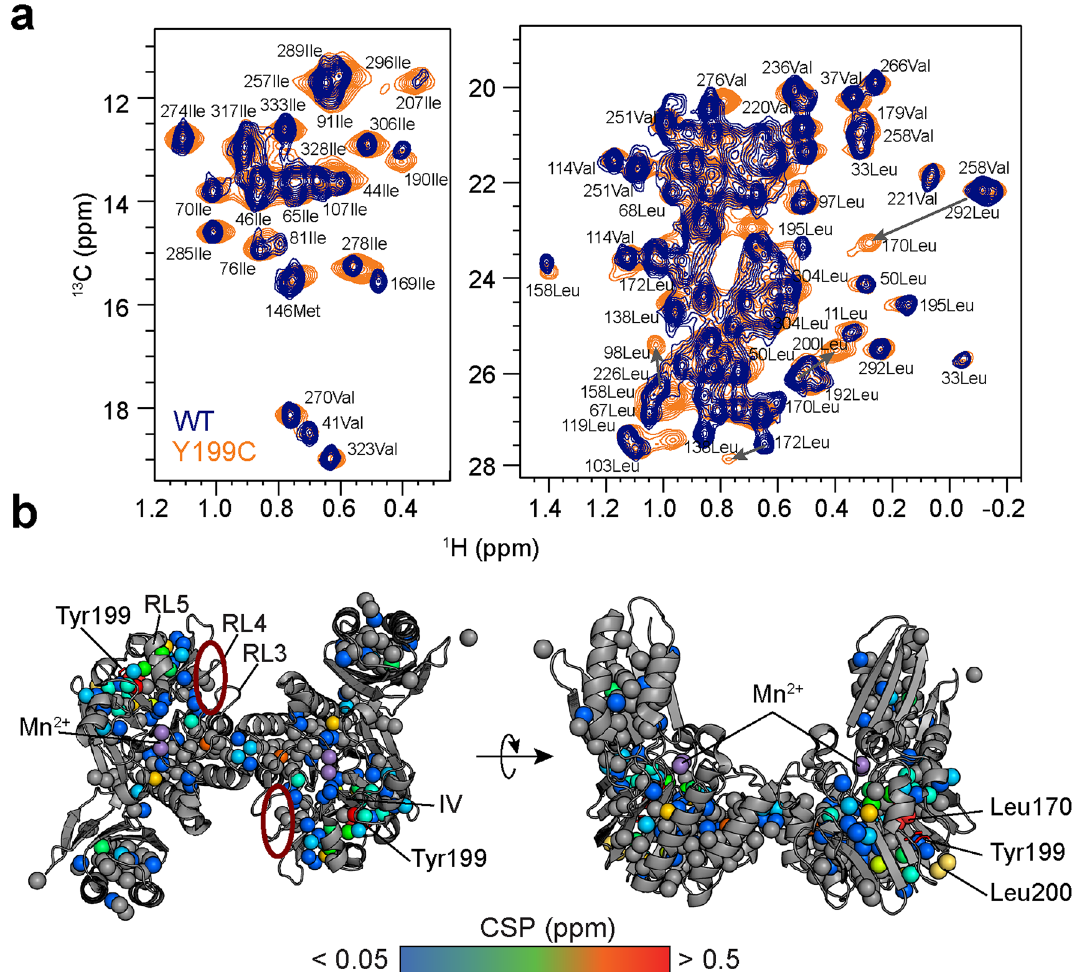
Figure 2. Pf Mre11 Y199C causes NMR chemical shift perturbations throughout the protein. ( a ) Overlays of wild type (blue) and Y199C (orange) Pf Mre11 ND 2D 13 C, 1 H methyl-TROSY NMR spectra. The two overlays are of different regions in the spectra. Peak assignments of many methyl groups are indicated, and grey arrows indicate the position of highly shifted peaks upon mutation. ( b ) The magnitude of side-chain methyl group CSPs between wild type and Y199C are colored on the structure of Pf Mre11 ND (PDB ID: 1II7) according to the associated gradient. Grey spheres are methyl groups that did not experience significant CSPs. The position of various residues, structural motifs, and the catalytic Mn 2+ ions (purple spheres) referred to in the text are indicated. A red circle indicates the position of the conserved basic